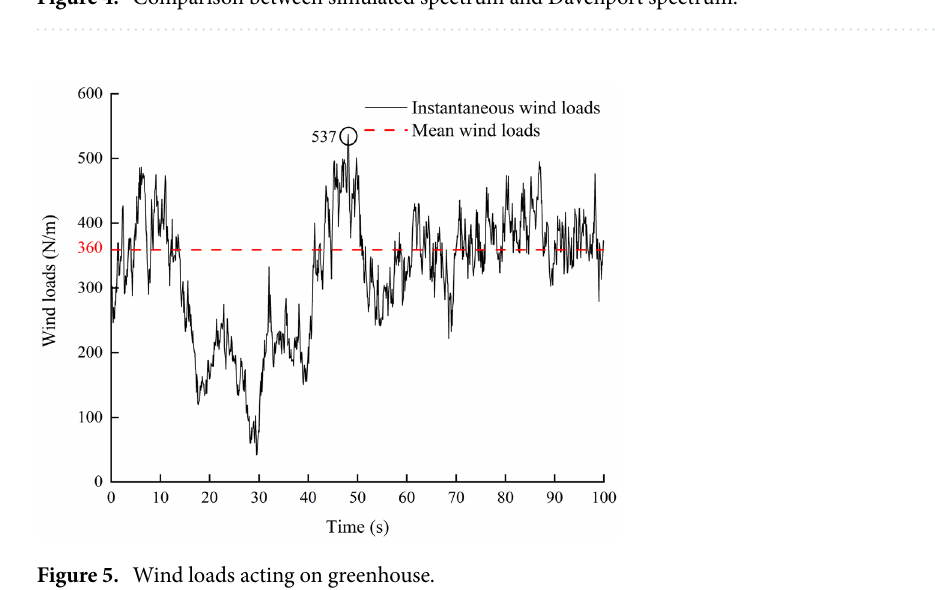
Figure 4. Comparison between simulated spectrum and Davenport spectrum.